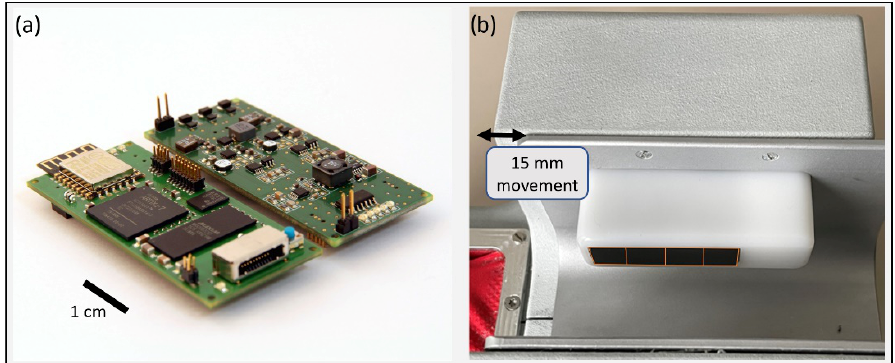
Figure 3. The compact, stackable ultrasound electronic module used in the device ( a ); the inbuilt ultrasound array ( b ).